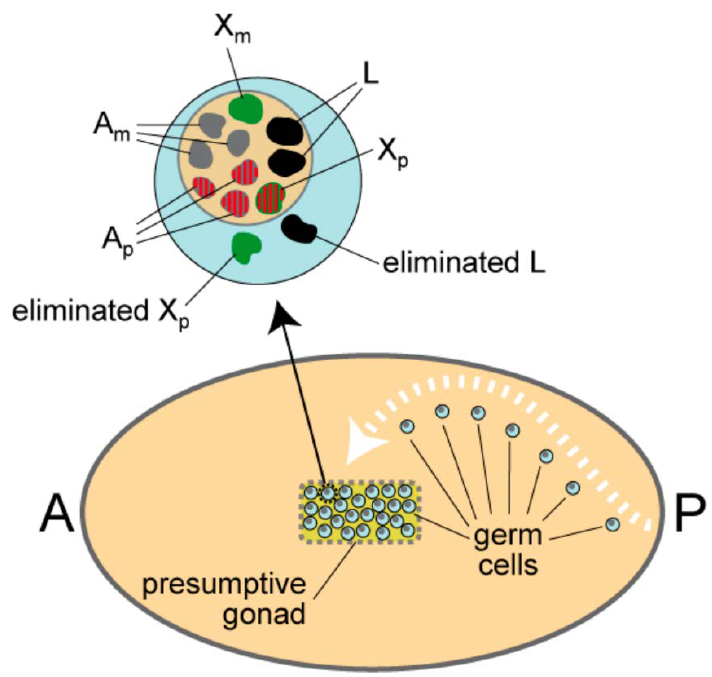
Figure 2. Elimination of L and Xp chromosomes in resting germ cells of the presumptive gonad. After rounds of cell division at the posterior of the embryo, germ cells enter a quiescent state and migrate to the presumptive gonad. Around 30 arrive in the gonad. In the gonad of both sexes, the chromosomes in the resting germ cells form distinct entities called pro-chromosomes, as shown in the magnified germ cell above the embryo. All but two L chromosomes are eliminated and one Xp is eliminated. The eliminated chromosomes lie in the cytoplasm. In the nucleus, the three paternal autosomes and the retained Xp are acetylated (acetylation is shown as red stripes); these four paternal chromosomes are also cytologically more diffuse than all the other chromosomes. Notably, the eliminated Xp is under-acetylated, which is also the case for all the other chromosomes. The L chromosomes are black, the autosomes are grey and the X chromosomes are green. Acetylation is shown as red stripes. Am are the maternal autosomes and Ap are the paternal autosomes. Xm is the maternal X chromosome and Xp is the paternal X chromosome. A is anterior and P is